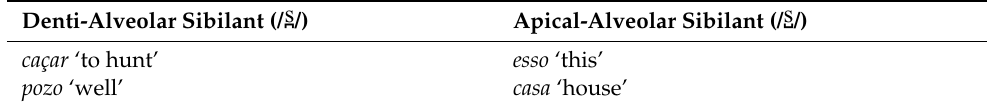
Table 1. The denti-alveolar and apical sibilants of early modern Spanish, according to Alarcos Llorach. Denti-Alveolar Sibilant